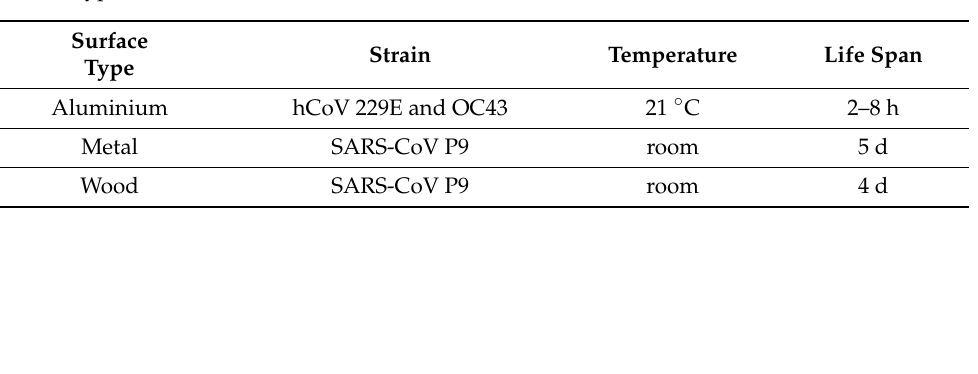
Table 1. Survival of the two main SARS-CoV-2 virus surrogates (HCoV 229E and SARS-CoV) on different types of inanimate